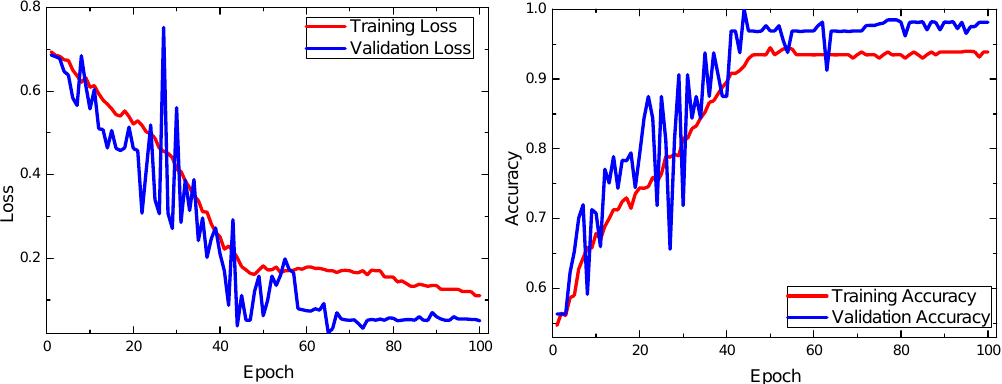
Figure 6. Model learning curves of fine-tuning for the network initialized with random weights of zero mean using the CAS-SIAT-Iris dataset: ( left ) training and validation loss curves, and ( right ) training and validation accuracy